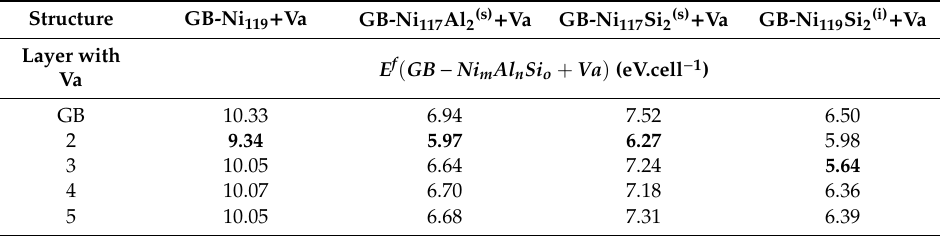
Table 7. Energy of formation of structures GB-Ni 119 + Va, GB-Ni 117 Al 2(s) + Va, GB-Ni 117 Si 2(s) + Va and GB-Ni 119 Si 2(i) + Va with three defects (GB, impurity, vacancy) for a vacancy in various layers. The quantity E f ( GB − Ni m Al n Si o + Va ) is defined with respect to the standard element reference states. The values written in bold correspond to the lowest energy configuration.